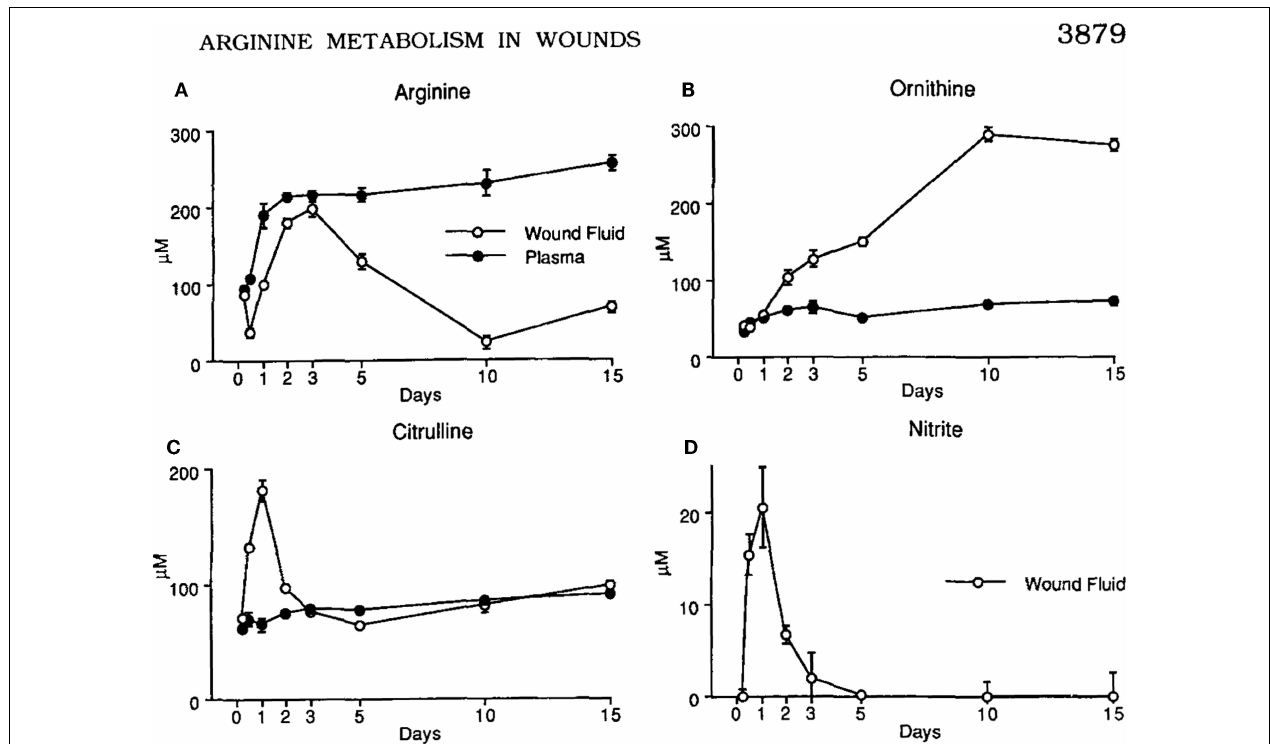
FIGURE 4 | (A, C) Following wounding, there is a 1-2 day “burst” of killer NO (measured as Citrulline and NO 2 ) in vivo , followed by (B, D) macrophages metabolizing arginine to the growth-promoting repair molecule, ornithine (and urea), as healing proceeds. From Ref. (14). Copyright 1990. The American